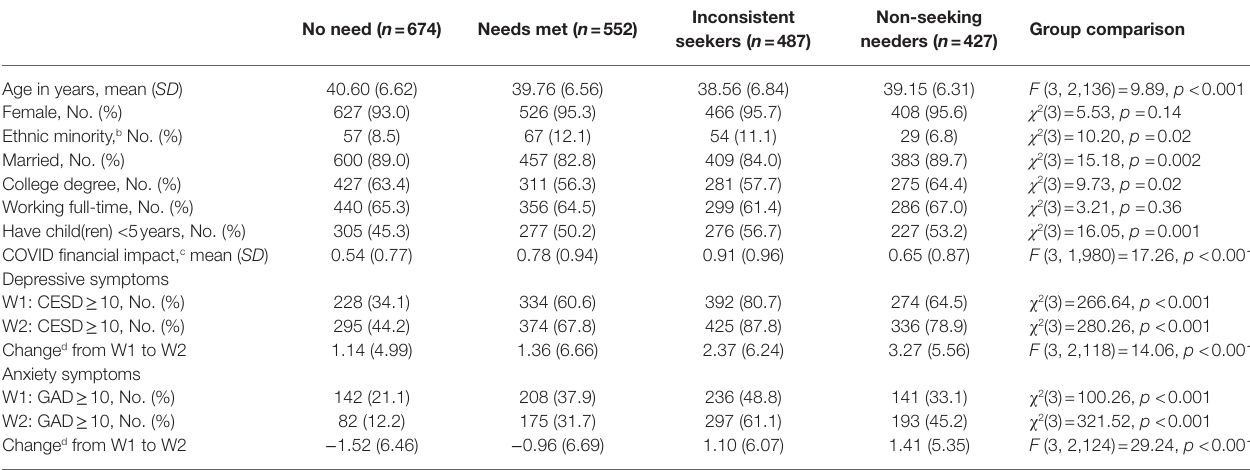
TABLE 1 | Sample characteristics by help-seeking group.